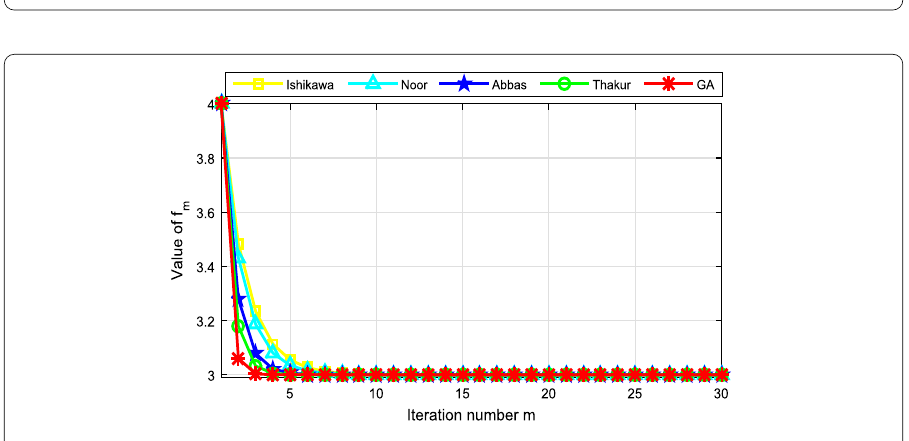
Figure 2 Graph corresponding to Table